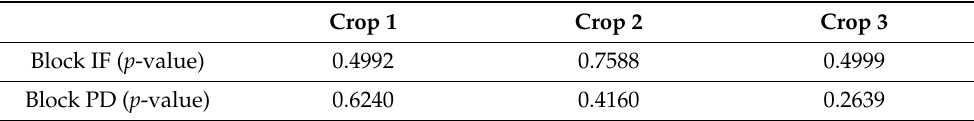
Table 4. Influence of Brassica carinata pellets (Crops 1 and 2) and tomato plant debris (Crop 3) on final commercial production in the IF and PD blocks.